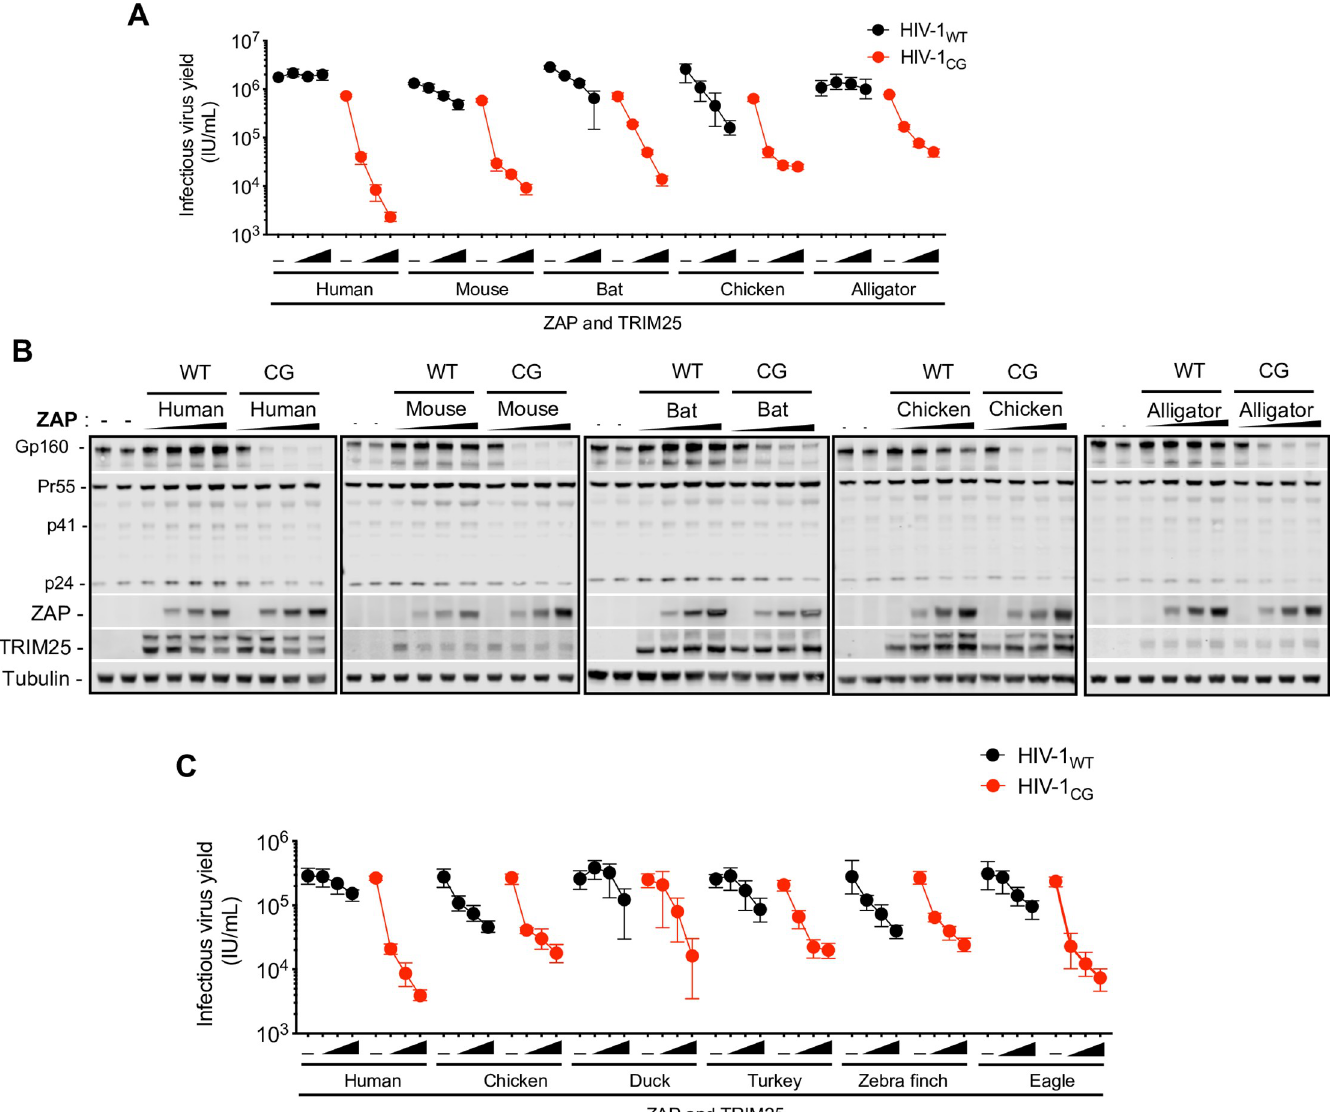
Fig 7. Avian ZAP proteins are less selective for CpG enriched HIV-1. (A-B) HEK293T ZAP -/- and TRIM25 -/- cells were co-transfected with indicated proviral plasmids, increasing amounts (0ng, 75ng, 145ng, or 290ng) of a plasmid encoding an FLAG-tagged human ZAP or mouse, bat, chicken and alligator ZAP chimeras and a fixed amount of a plasmid encoding a cognate HA-TRIM25 protein. After 48h, infectious virus yield was determined using MT4-R5-GFP target cells (A). Whole cell lysates were analysed by western blotting probing with antibodies against HIV-1 proteins ZAP-FLAG and TRIM25-HA (B). (C) HEK293T ZAP -/- and TRIM25 -/- cells were transfected with HIV-1 proviral plasmids, along with increasing amounts (0ng, 75ng, 145ng, or 290ng) of a plasmids expressing human ZAP or ZAP chimeras from various avian species. For cells transfected with human ZAP, a fixed amount of a human TRIM25 expression plasmid was co-transfected, while for the avian ZAP chimeras, chicken TRIM25 was used. After 48h, infectious virus yield was determined using MT4-R5-GFP target